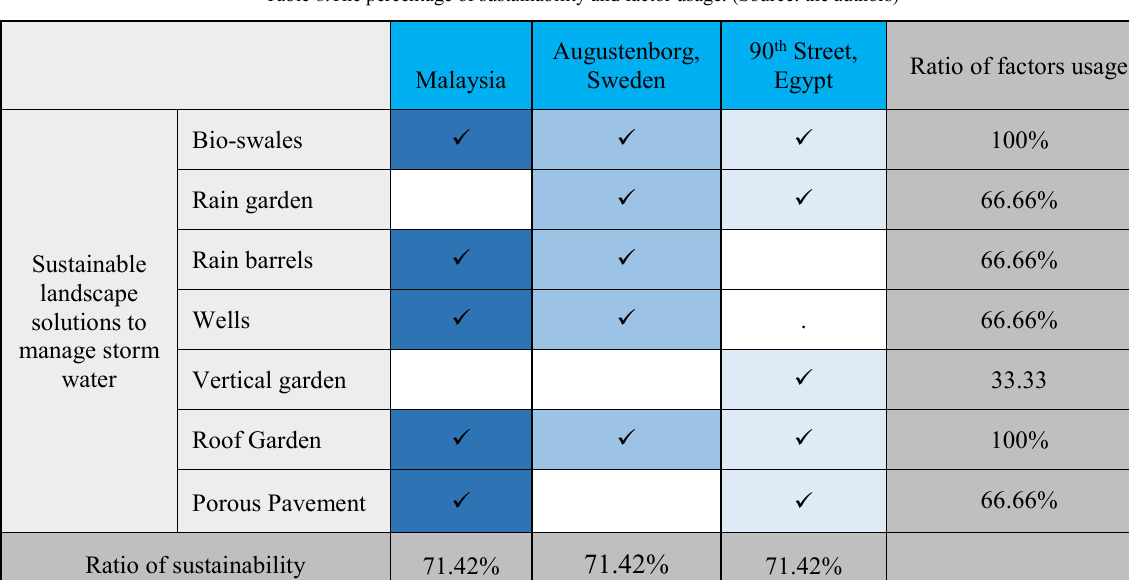
Table 8.The percentage of sustainability and factor usage. (Source: the authors)